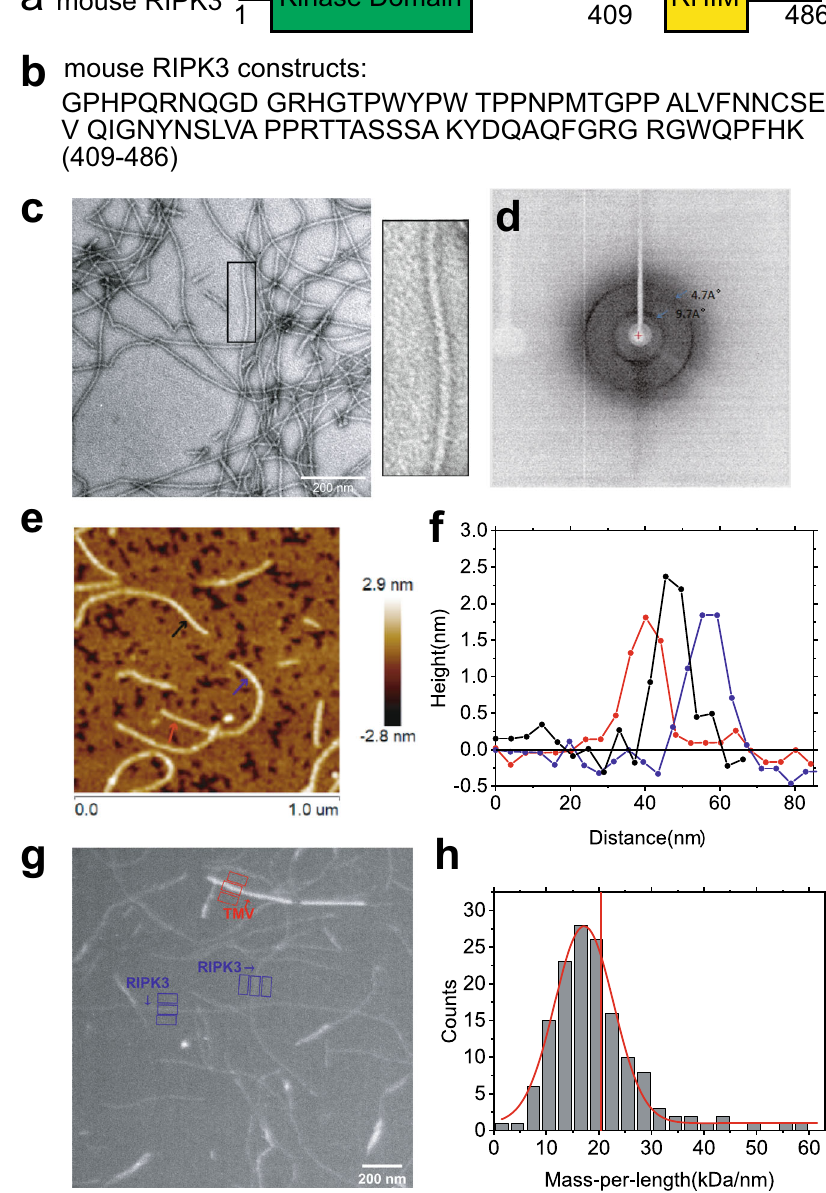
Fig. 2 The EM, X-ray diffraction, and AFM images of mouse RIPK3 fi brils. a The domain components of the full-length mouse RIPK3. b Protein sequence of mouse RIPK3 construct used for structural elucidation. c Electron micrograph of amyloid fi brils (scale bar 200 nm). Mouse RIPK3 fi brils have the straight, unbranched appearance of typical amyloid fi brils. The picture on the right is an expanded view of the boxed area on the left image. The experiment was repeated for more than 5 times. d The X-ray diffraction of mouse RIPK3 fi brils. The blue arrow indicated equatorial and meridional re fl ection at about 9.7 Å and 4.7 Å resolutions, respectively. The experiment was repeated for 3 times. e The AFM image of mouse RIPK3 fi brils on mica surface. f The height pro fi le at three positions of mouse RIPK3 fi brils corresponding to the three positions indicated by the arrows in ( e ), showing fi bril diameter about 1.8 ± 0.2 nm. g One BT-TEM image of mouse RIPK3 fi brils, with tobacco mosaic virus (TMV) particles as standards for MPL measurement. h MPL histogram of mouse RIPK3 fi brils derived from BT-TEM images. Vertical red line indicated MPL value of 20.3 kDa/nm, the expected value if a single molecule lies in the cross- β unit of the fi bril. The variations in the background intensity is analyzed in Supplementary Fig. 2. Figure 1e was a representative image of nine images from three sample preparations and BT-TEM in Fig. 1g was a representative image of more than 30 images from about ten sample